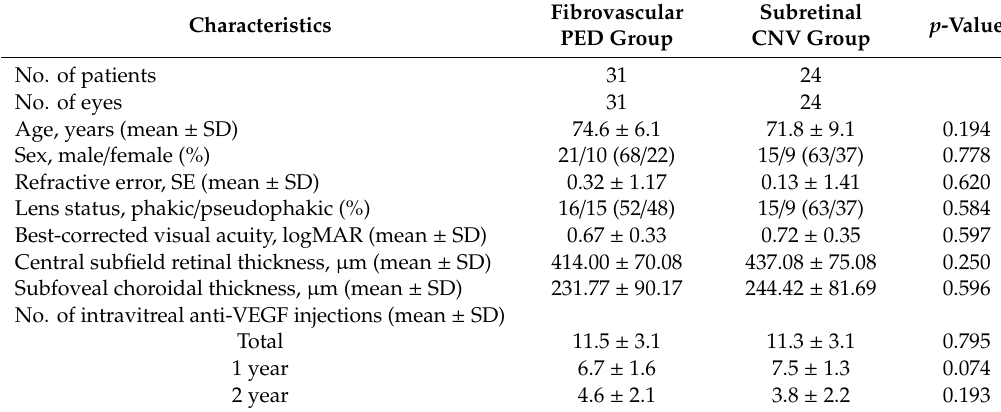
Table 1. Patient demographics and baseline ocular findings.